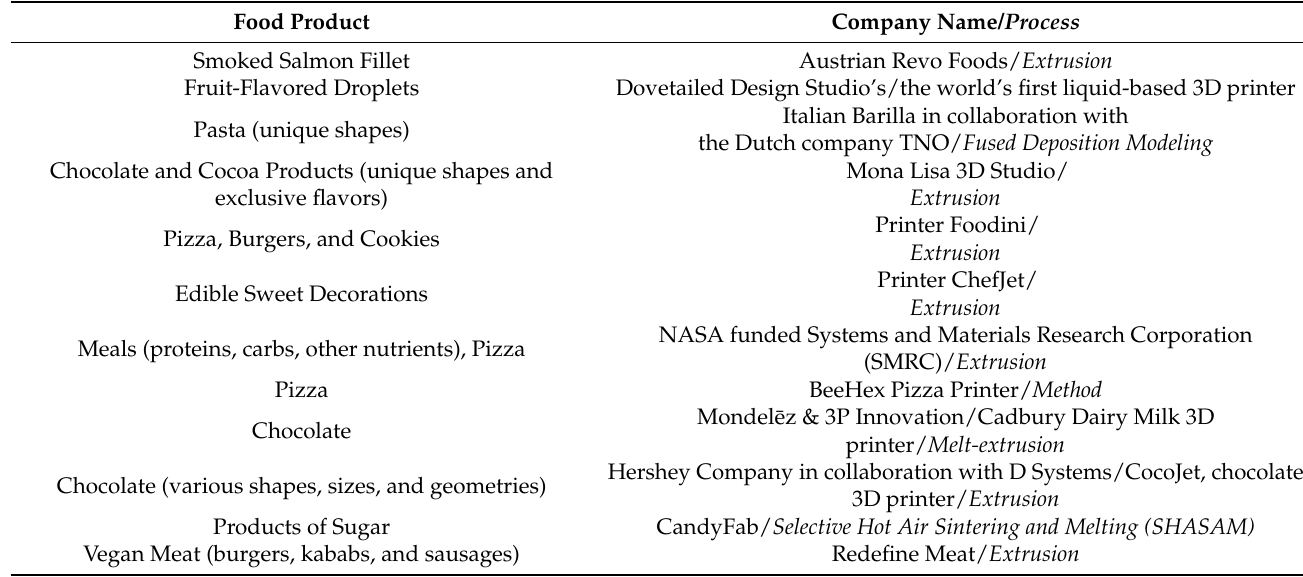
Table 2. Commercially available food products obtained with 3D